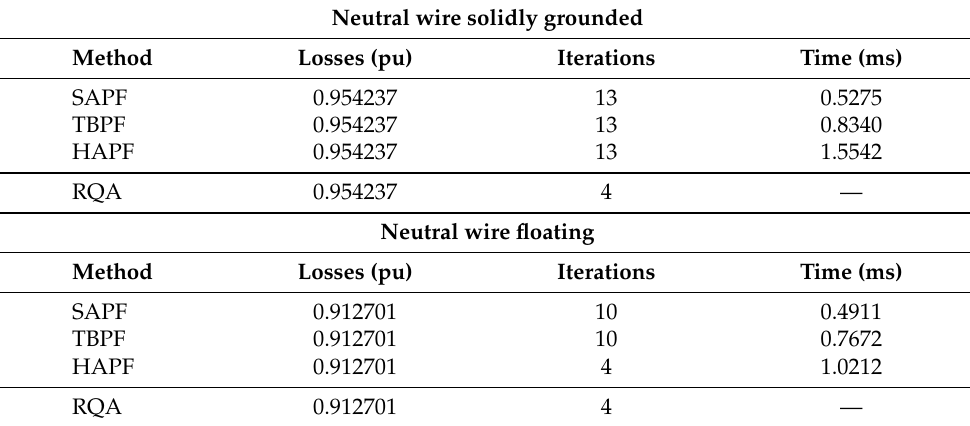
Numerical results in Table 5 show